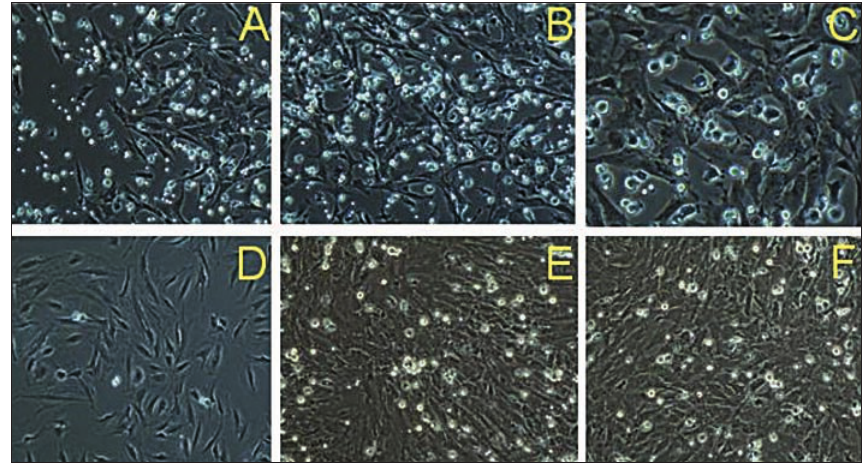
Fig. 1. Photomicrographs of rat mesenchymal stem cells after harvest 24 h (A), at 3 days (B), at 4 days (C), small colonies (D), after 1st passage (E), 3nd passage (F)